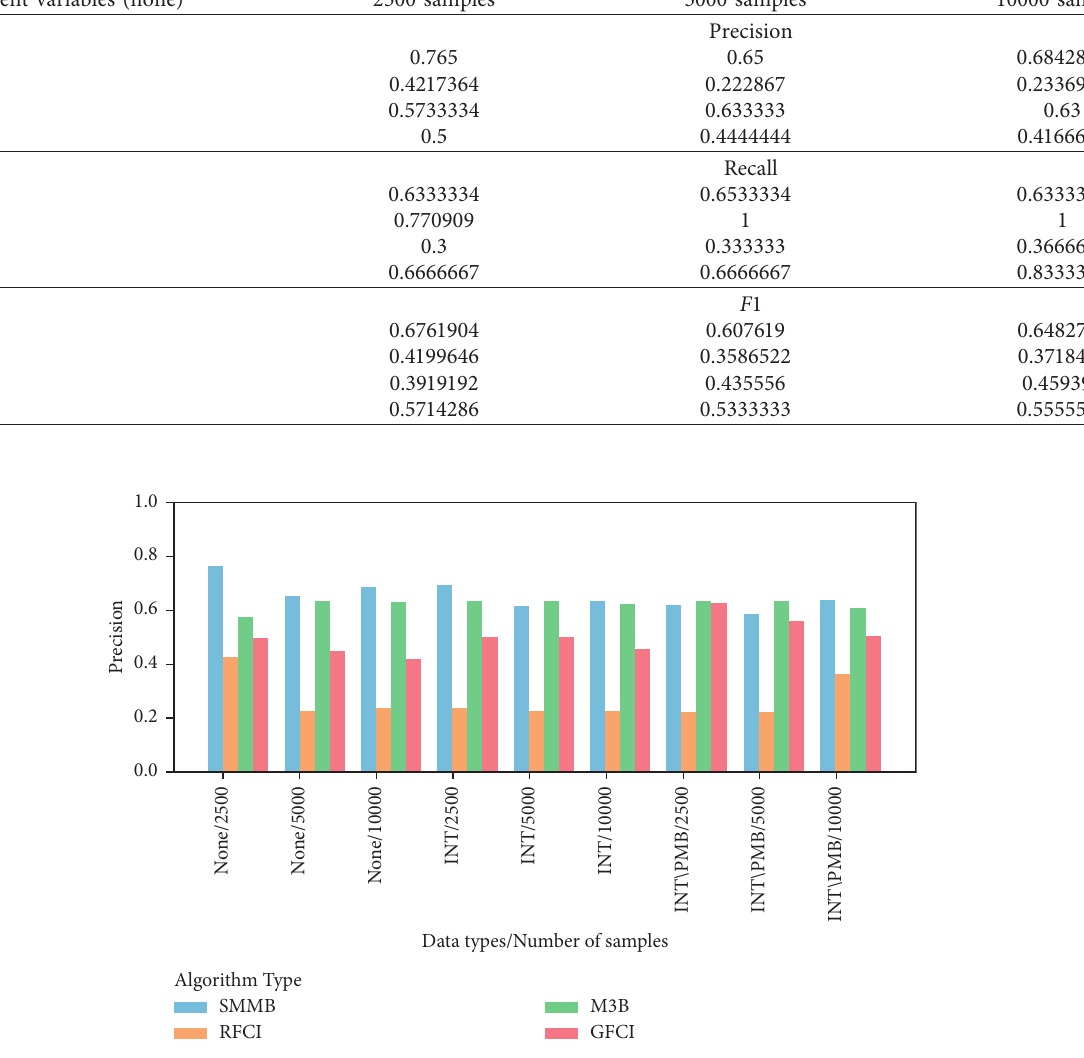
Figure 4: Comparison of SMMB, RFCI, M3B, and GFCI in